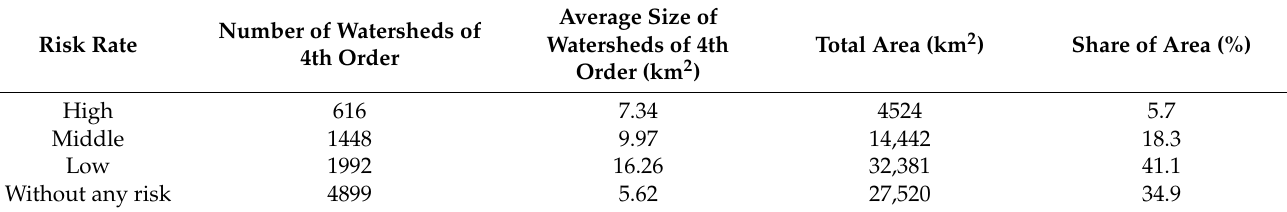
Table 3. The extent of territory with individual degree of risk of flash